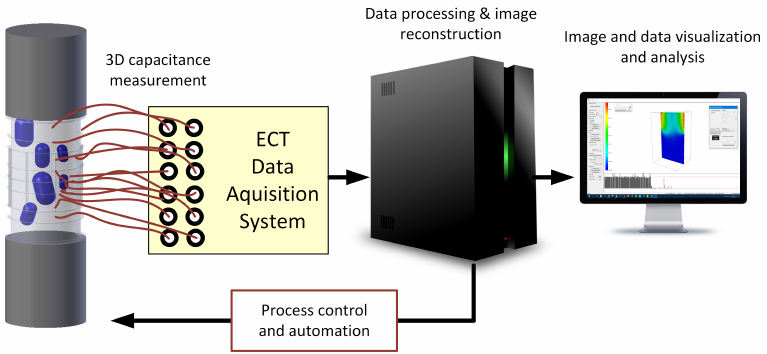
Figure 1. 3D ECT system and its